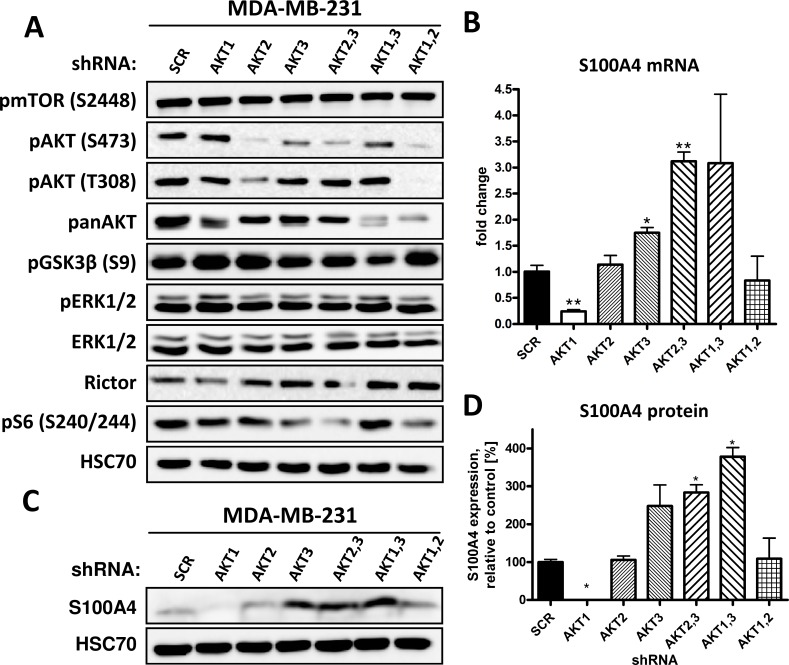
Knockdown of AKT3 increases the expression of S100A4 protein.(A) AKT signaling pathway activity after downregulation of AKT isoforms was analyzed by Western blot with antibodies directed against the indicated proteins. HSC70 was used as loading control. (B) Relative mRNA levels of S100A4 were measured by qPCR (Bars: SD. *, p < 0,05. **, p < 0,01). (C) Expression of S100A4 in MDA-MB-231 control and AKT isoform knockdown cells was analyzed by Western blot, HSC70 was used as loading control. (D) S100A4 expression was quantified from Western blot analysis of triplicates and data were normalized to corresponding HSC70 controls (Bars: SD. *, p < 0,05).